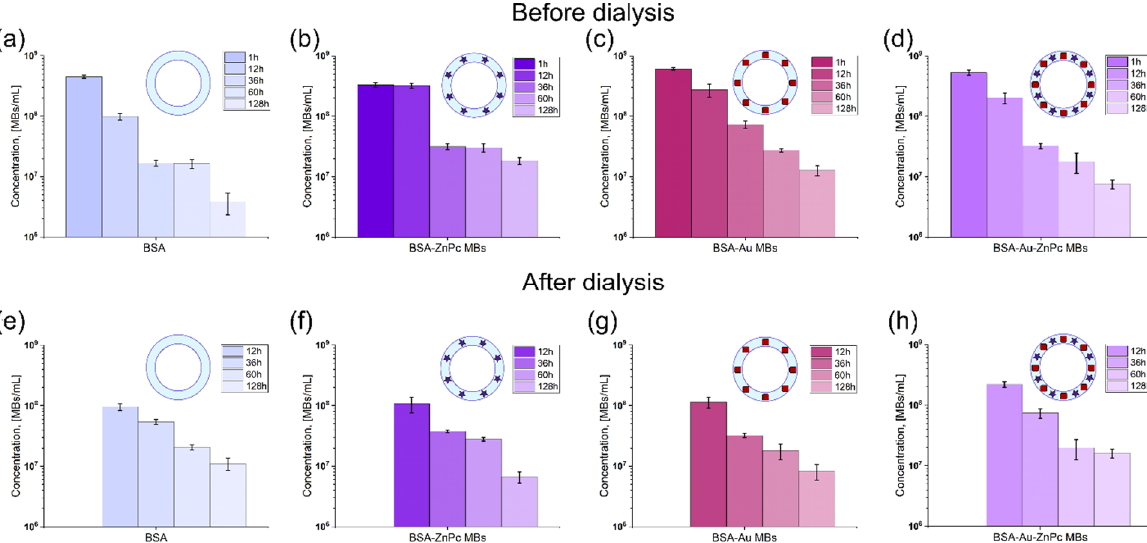
Figure 3. Microbubbles initial concentrations and their stability during storage without dialysis at 1, 12, and 36, 60 and 128 h after preparation: ( a ) microbubbles with the BSA shell only (BSA MBs), ( b ) microbubbles functionalized with ZnPc (BSA-ZnPc MBs), ( c ) microbubbles functionalized with AuNCs (BSA-Au MBs), ( d ) microbubbles stabilized with AuNCs and ZnPc (BSA-Au-ZnPc MBs); and for dialyzed probes at 12, 36, 60, and 60 h after preparation: ( e ) microbubbles with the BSA shell only (BSA MBs), ( f ) microbubbles functionalized with ZnPc (BSA-ZnPc MBs), ( g ) microbubbles functionalized with AuNCs (BSA-Au MBs), ( h ) microbubbles stabilized with AuNCs and ZnPc (BSA-Au-ZnPc MBs). All samples were stored at 4°C. For convenience, concentration values are provided on a logarithmic scale.